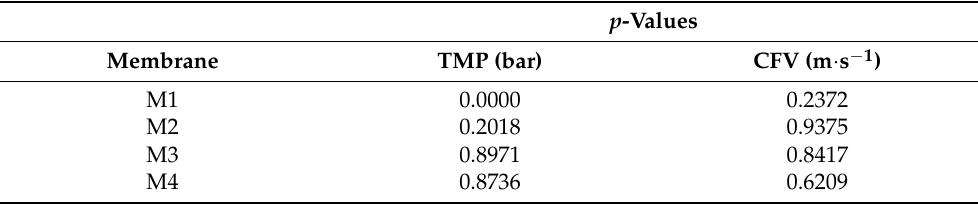
Table 6. Effect of TMP and CFV on salt rejections in terms of p -values.